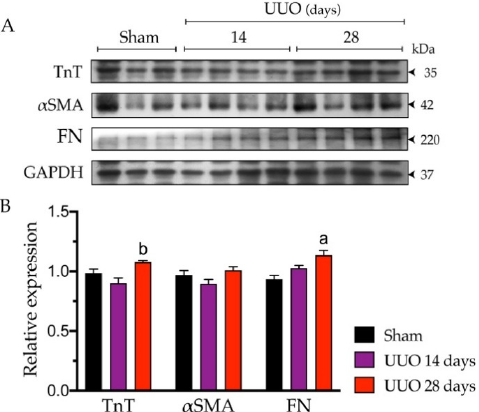
Figure 3. Measurements of proteins related to cardiac damage in animals with 14 and 28 days of unilateral ureteral obstruction (UUO). ( A ) Western blot image. ( B ) Quantitative immunoblot analysis. Data represent mean ± SEM of 3–4 independent experiments. a p ≤ 0.05 vs. sham; b p ≤ 0.05 vs. UUO 14 days. TnT: troponin T; α SMA: alpha-smooth muscle actin; FN: fibronectin; GAPDH: glyceraldehyde-3-phosphate dehydrogenase. Table 2. Pro-inflammatory cytokine content and enzymes related to renal function in blood serum. Pro-inflammatory cytokines content in blood serum obtained from sham and unilateral ureteral ob- struction (UUO) rats at 14 and 28 days by enzyme-linked immunosorbent assay (ELISA), as well as the creatinine and blood urea nitrogen (BUN) levels, were determined. Data are the mean ± SEM of 5–6 different animals in each experimental group a p ≤ 0.05 vs. sham; b p ≤ 0.05 vs. UUO 14 days; c p ≤ 0.05 vs. UUO 14 days. IL-6: interleukin-1; IL-6: interleukin-6; TNF- α : tumor necrosis factor alpha.